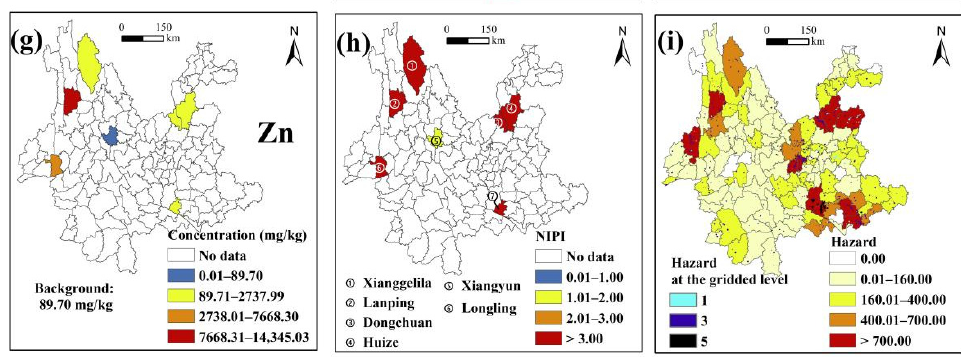
Figure 9 . Verification of the hazard score. Concentrations of heavy metals ( a–g ). Nemerow integrated pollution index (NIPI) ( h ). Hazard at the gridded and the county levels ( i ). The background values of the heavy metals were obtained from Bai, Cui [67].